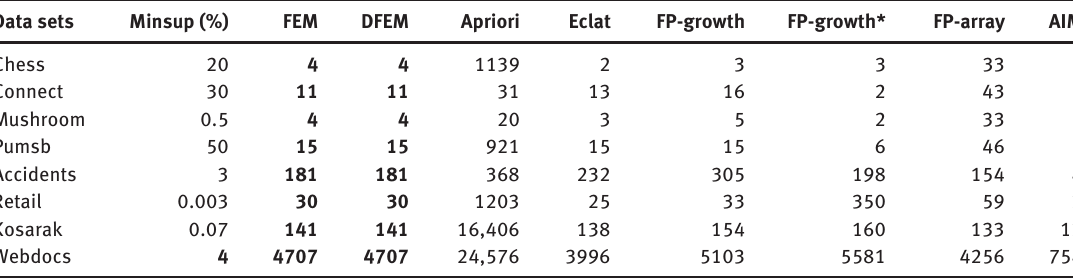
Table 5. Peak Memory Usage of FEM, DFEM, and Other